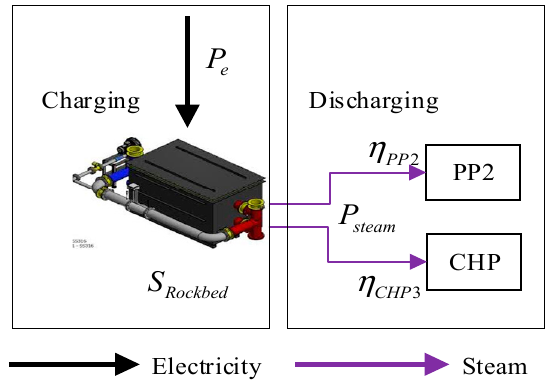
Figure 11. PHS charging and discharging phenomena.